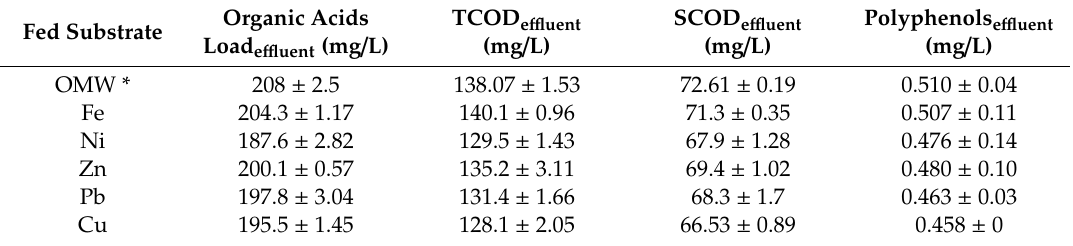
Table 5. Chemical characteristics of the e ffl uent of the anaerobic digestion process for all tests. Organic Fed Substrate